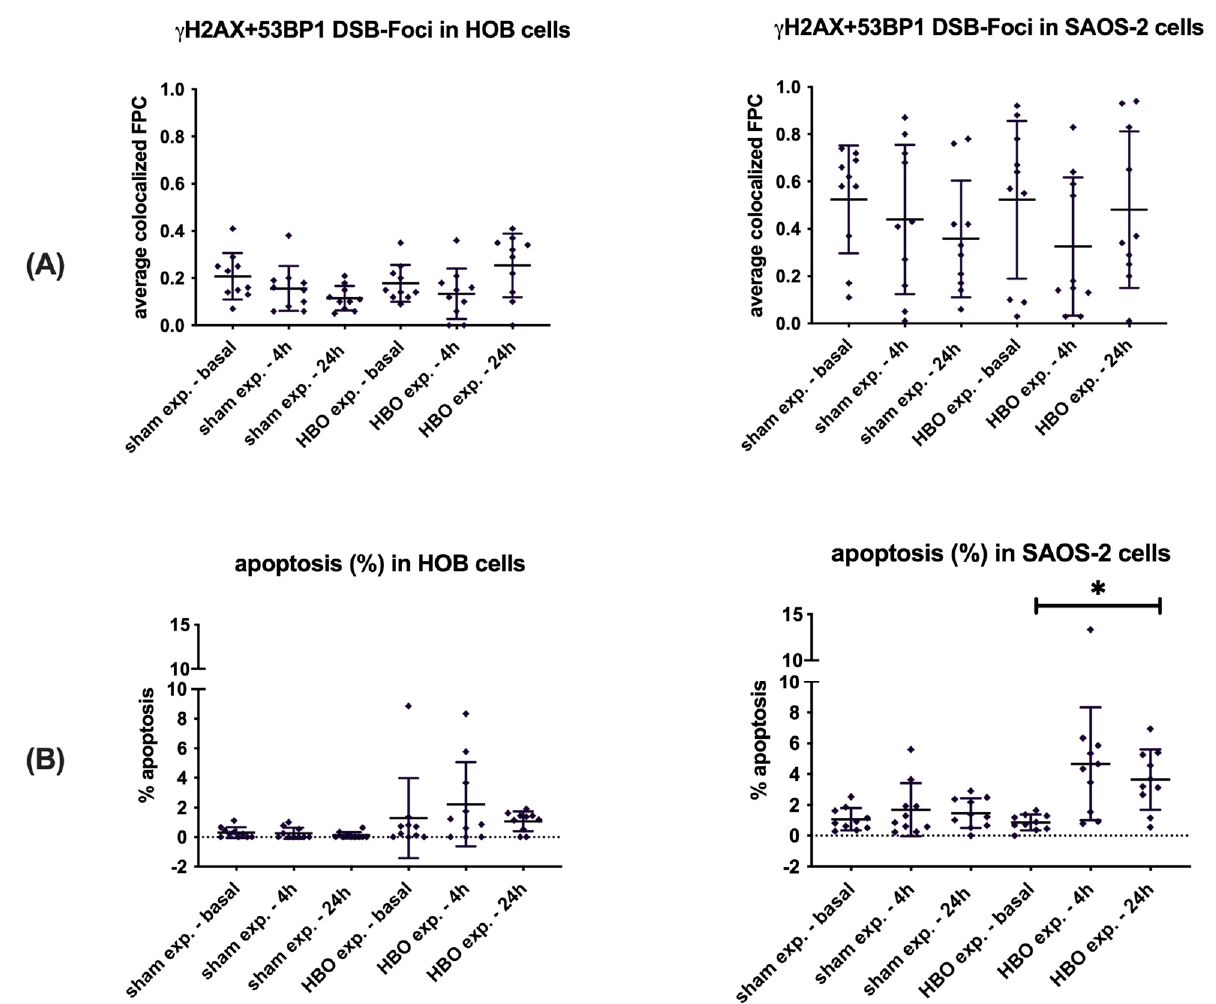
Figure 3. Detection of γ H2AX+53BP1 double-strand break foci ( A ) and apoptosis ( B ) in HOB and SAOS-2 cells after exposure to hyperbaric oxygen (HBO exposure) and ambient air (sham exposure). Data are presented as mean ± SD; p -value: * p < 0.05.